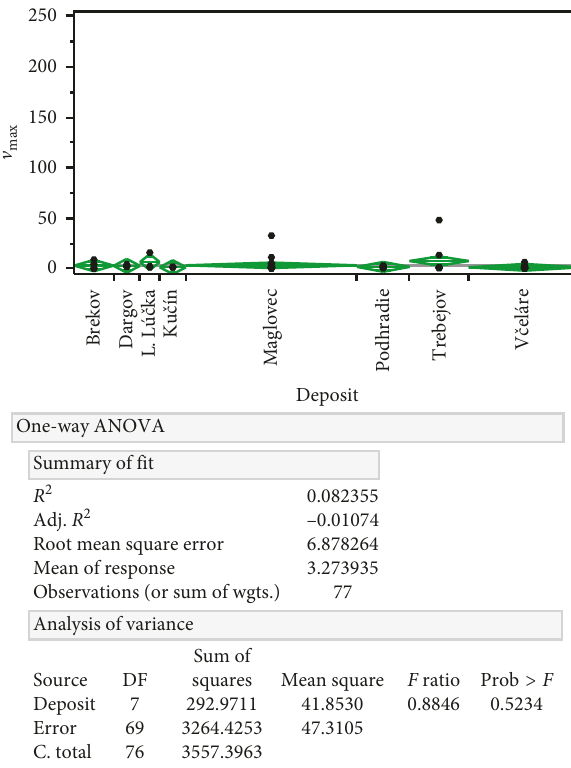
Figure 10: ANOVA v -deposit, distance to 80m. Figure 11: ANOVA v max